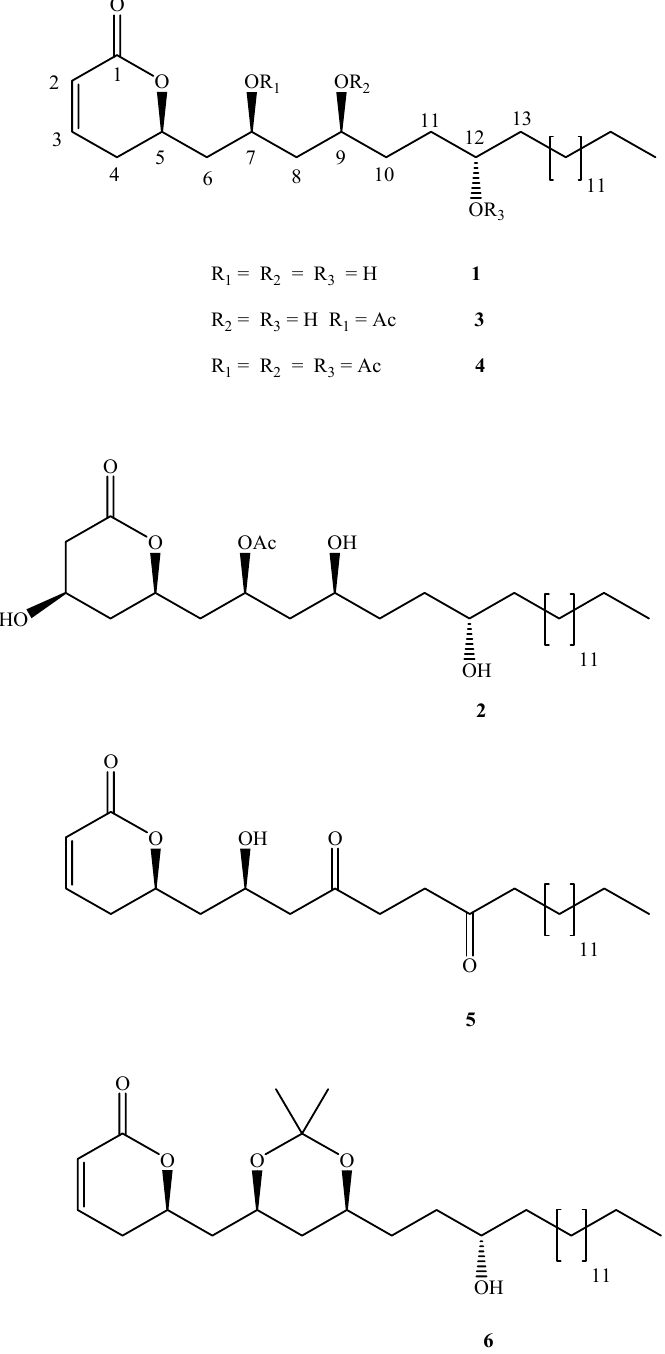
Figure 1. Structures of passifloricin A ( 1 ) and several